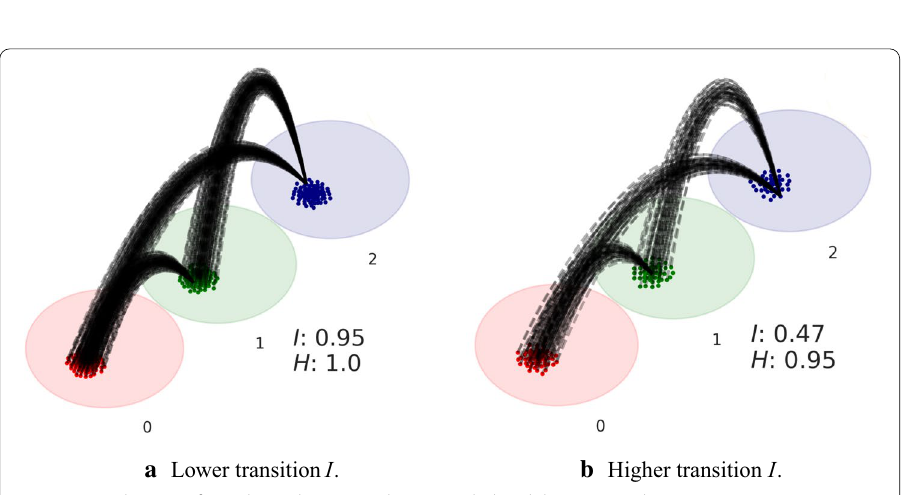
Fig. 10 Visualization of coupling edges in synthetic coupled multilayer